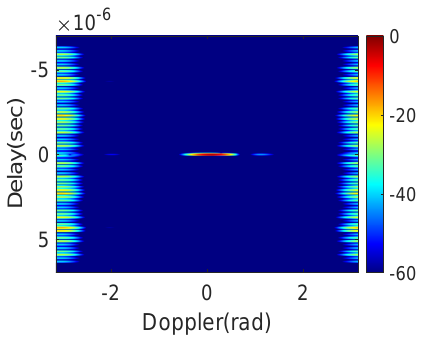
Figure 7. The slices across at Delay = 0 of the ambiguity functions of BD algorithm and GBD procedure.